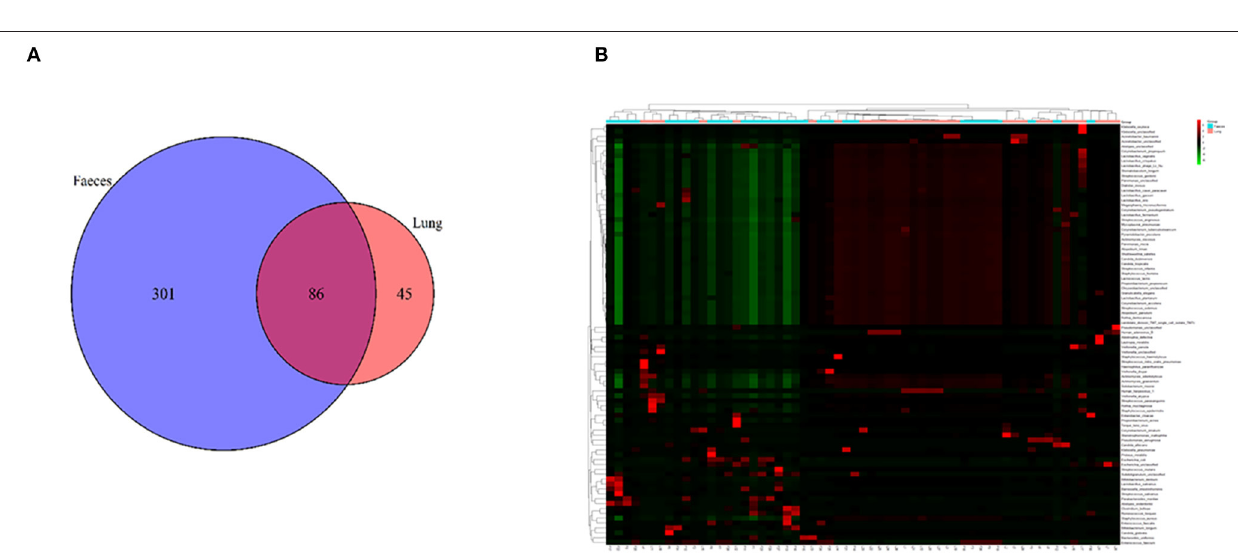
out that the lower gastrointestinal tract might be the